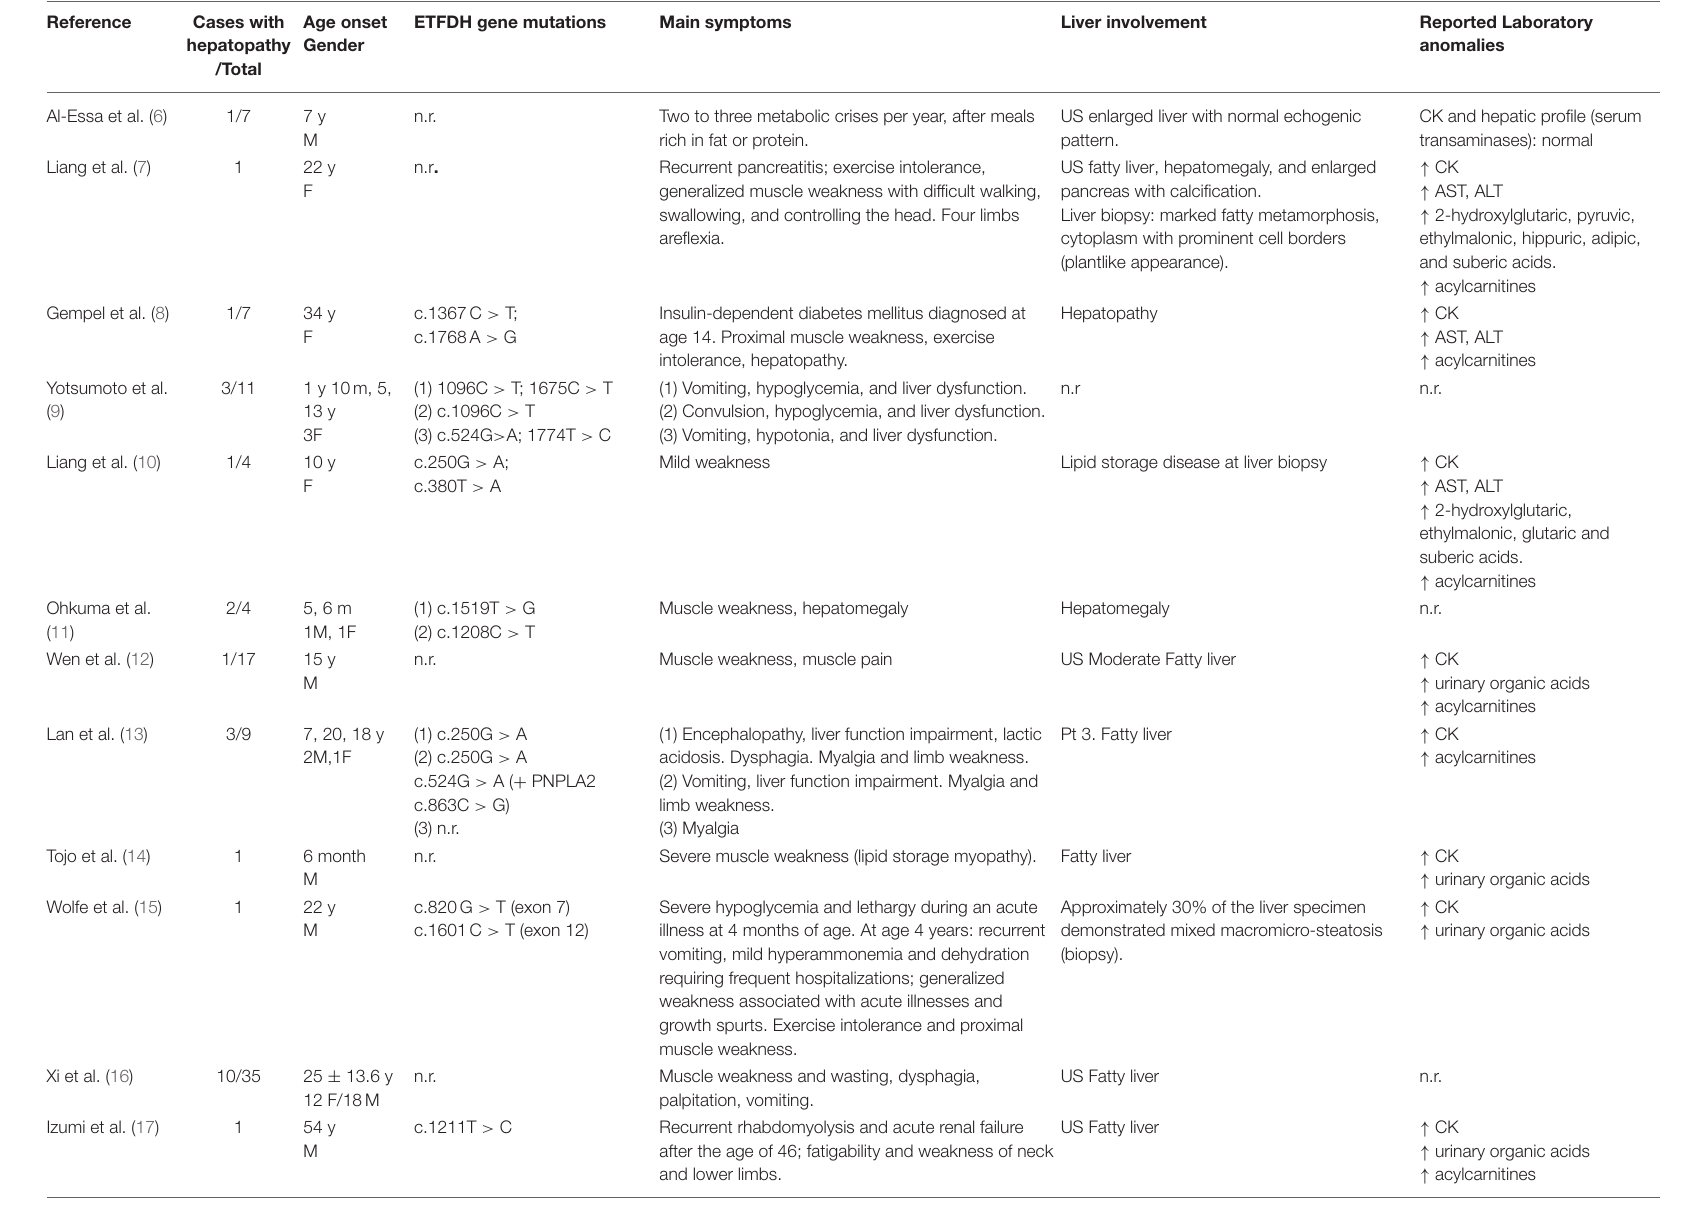
TABLE 1 | Summary of the systematic review of the literature with studies reporting liver involvement in patients with Multiple Acyl-CoA Dehydrogenase Deficiency